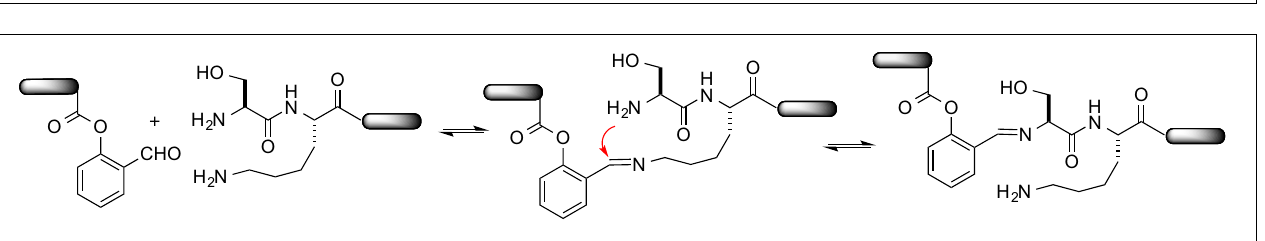
FIGURE 3 | Acidolysis of N,O-benzylidene acetal intermediate.